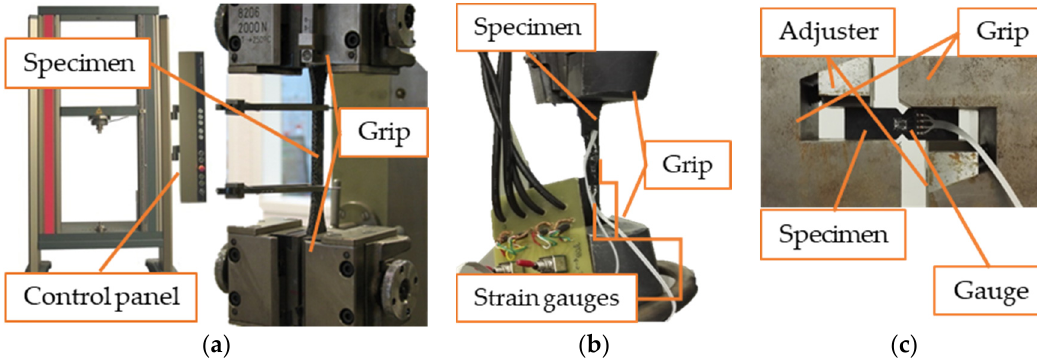
Figure 3. ( a ) Zwick 10 kN experimental equipment; ( b ) two-directional strain measurement set-up; ( c ) Iosipescu shear test.